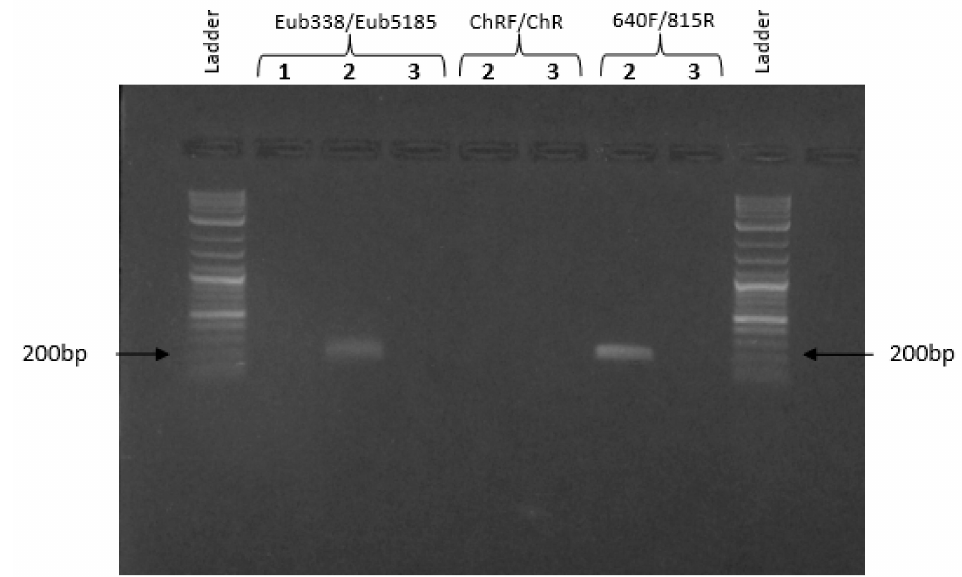
Figure 6. PCR products on 1.5% agarose gel. A 0.1–1 kb ladder was used as the DNA size marker. ( 1 ) limestone, ( 2 ) groundwater, and ( 3 ) no template control.